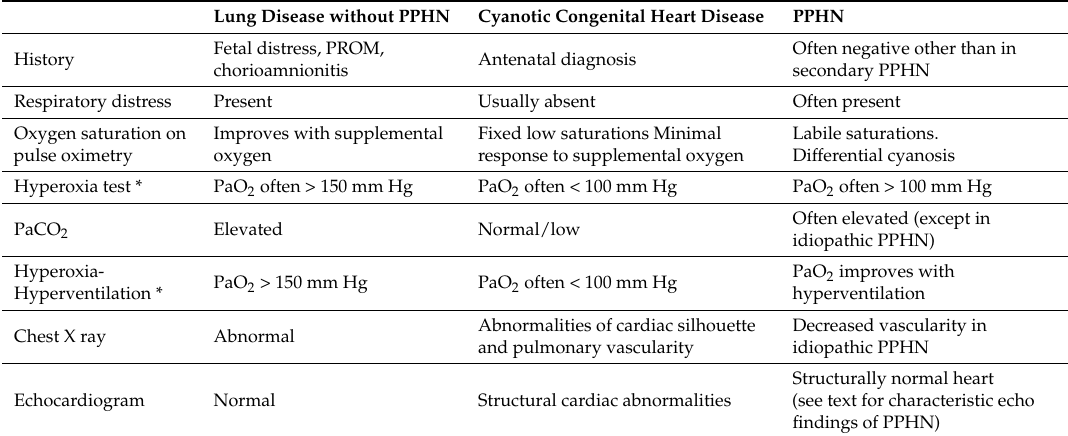
Table 1. Differential diagnosis of hypoxemia in newborn